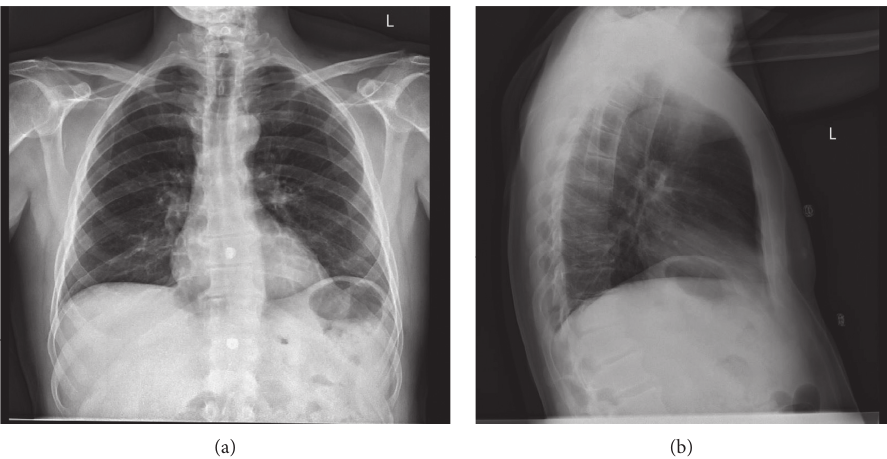
Figure 1: Frontal (a) and lateral (b) chest X-ray images demonstrating no abnormalities or signs of pericardial effusion.